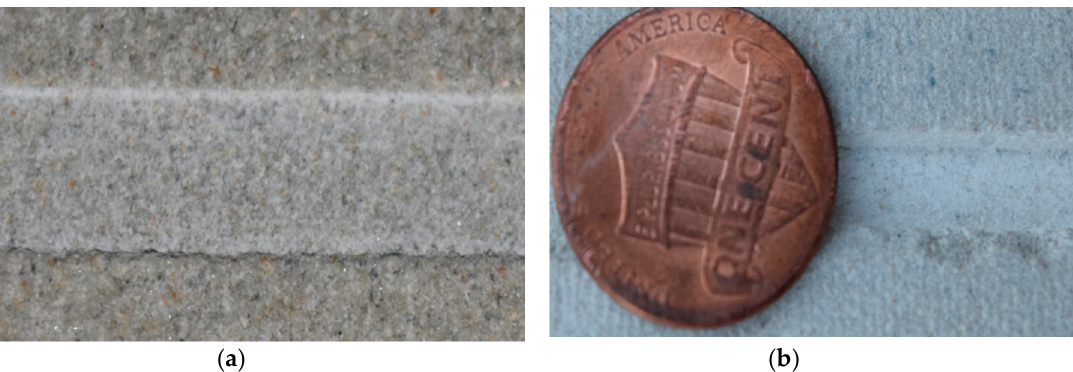
Figure 4. Surface roughness of Berea sandstone sample after the cutting process: ( a ) DOC = 0.1 mm, ( b ) DOC = 0.4 mm. Both pictures are sharing the same scale but roughness cannot be noticed by naked eyes.